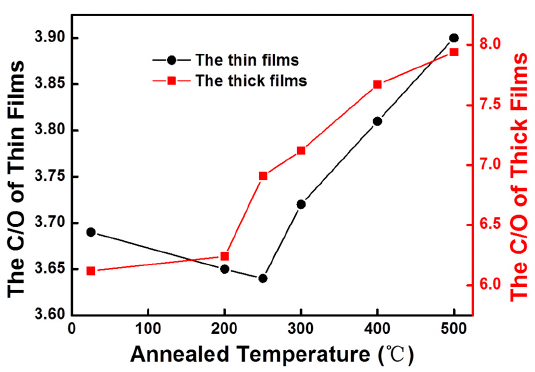
Figure 6. The fitted XPS C1s of original FL-C:H films ( a ), the values of sp 2 /sp 3 for thin and thick FL- C:H films at different annealed temperatures ( b ).